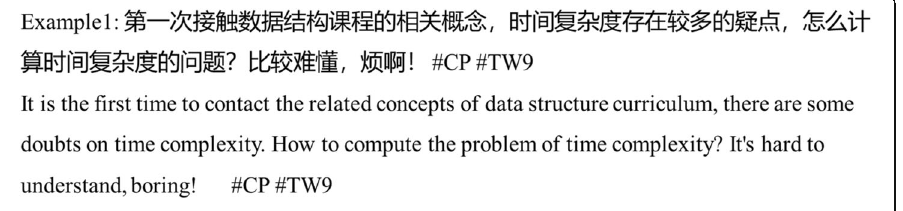
Fig. 1 An example of the time label assigned to a